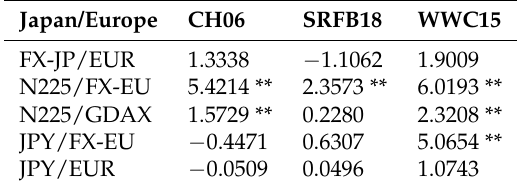
Table 5. Test statistics for stationary fractional cointegration between Japan and